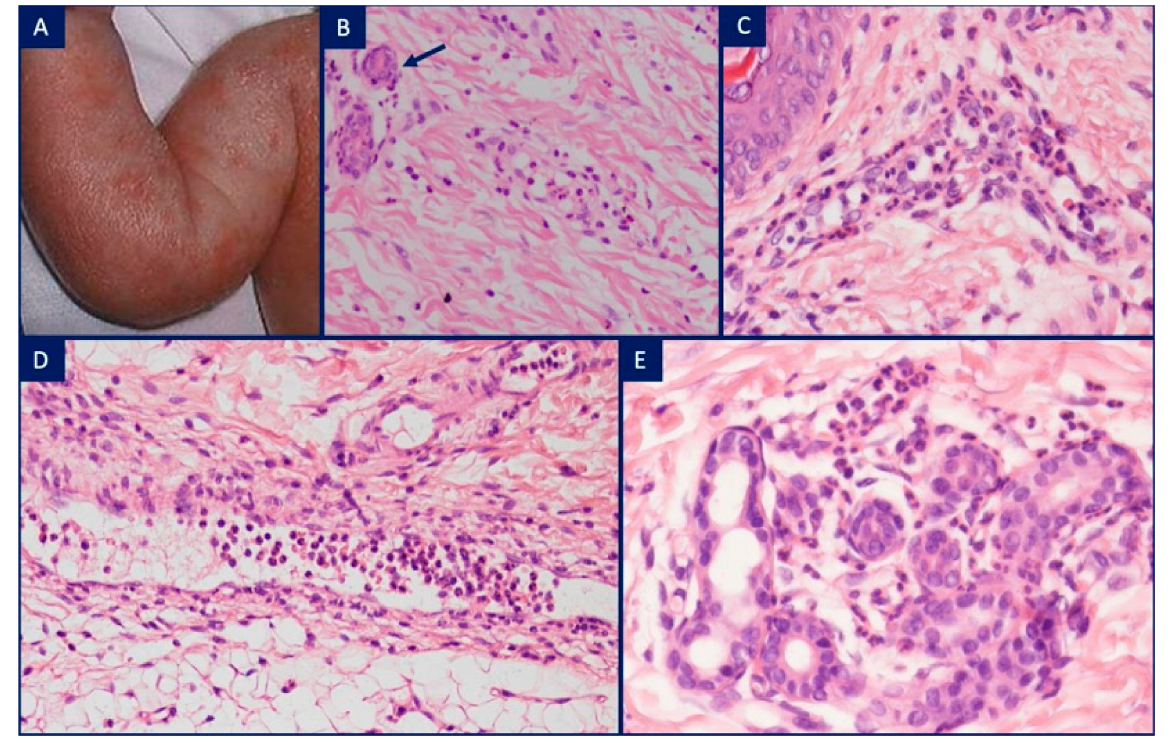
Figure 3. Neutrophilic urticarial dermatitis (NUD) in neonatal-onset multisystem inflammatory disease (NOMID). ( A ) Fe- male newborn with an urticarial eruption associated with recurrent fever, increased serologic inflammatory markers, and aseptic purulent meningitis; ( B ) H&E, × 10. A perivascular, interstitial and peri-eccrine (arrow) mononuclear cell infiltrate admixed with neutrophils and rare eosinophils; ( C ) H&E, × 20. A perivascular neutrophilic infiltrate with leukocytoclasia but no fibrinoid necrosis in vessel walls; ( D ) H&E, × 10. Dilated lymphatics containing numerous neutrophils; ( E ) H&E, × 20. Peri-eccrine neutrophilic